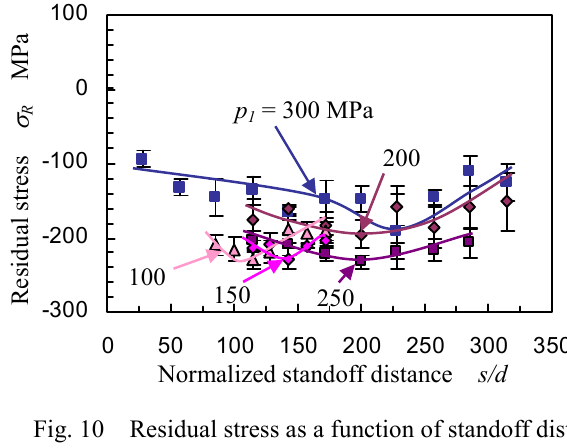
Fig. 10 Residual stress as a function of standoff distance ( d = 0.35 mm, p = 0.1 MPa, t = 1 2 p